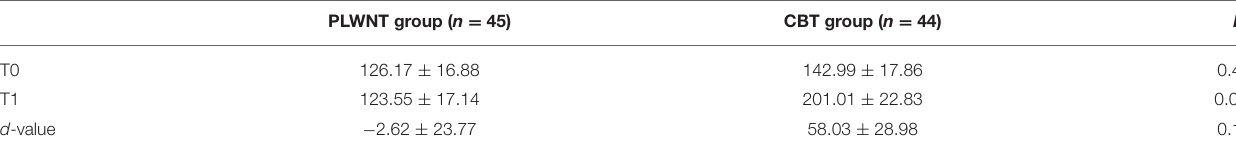
TABLE 4 | The distribution of plasma NPY values of the three